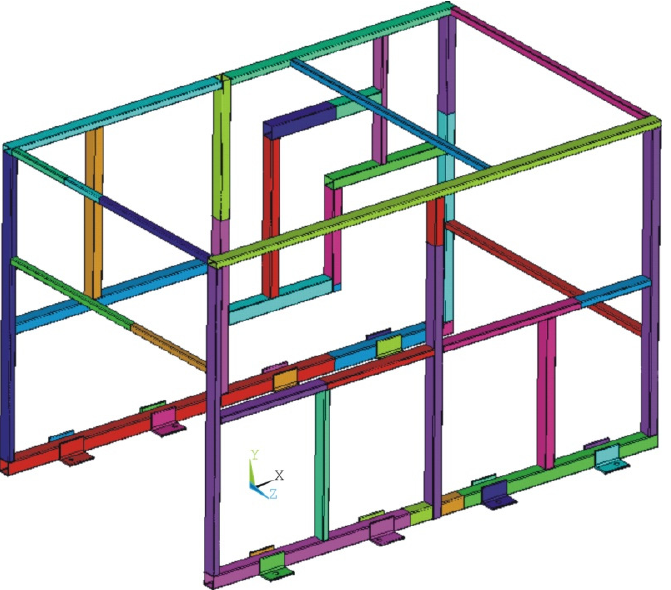
Figure 15. Detailed model of the validation structure, modeled with volume-type